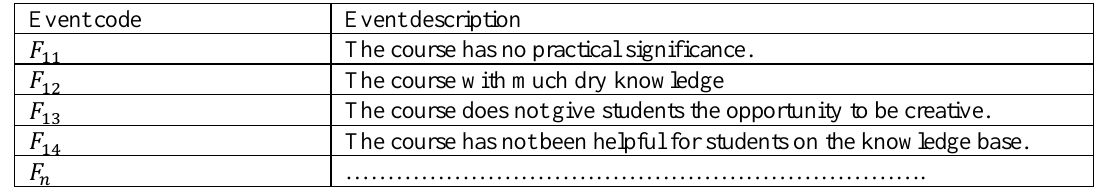
Table 2. Example